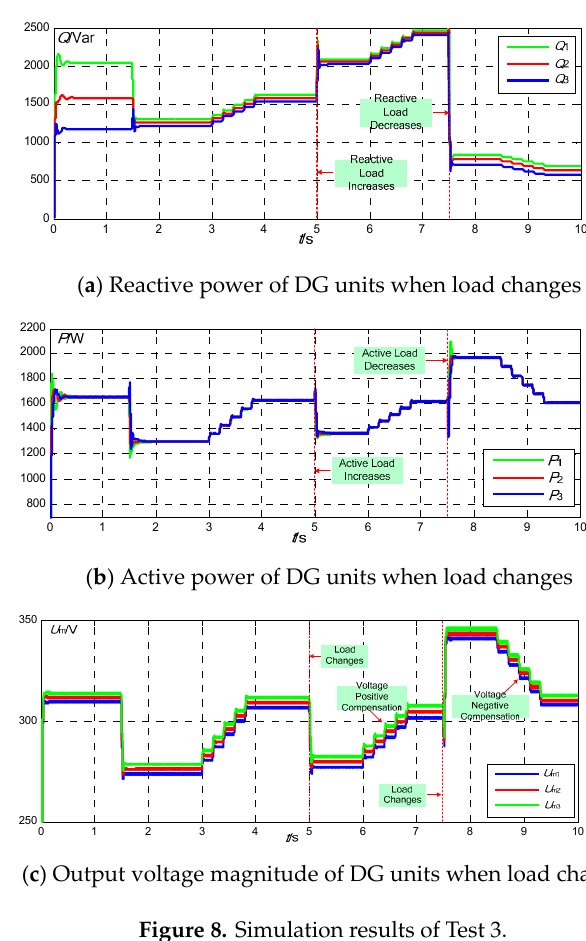
Figure 8. Simulation results of Test 3.